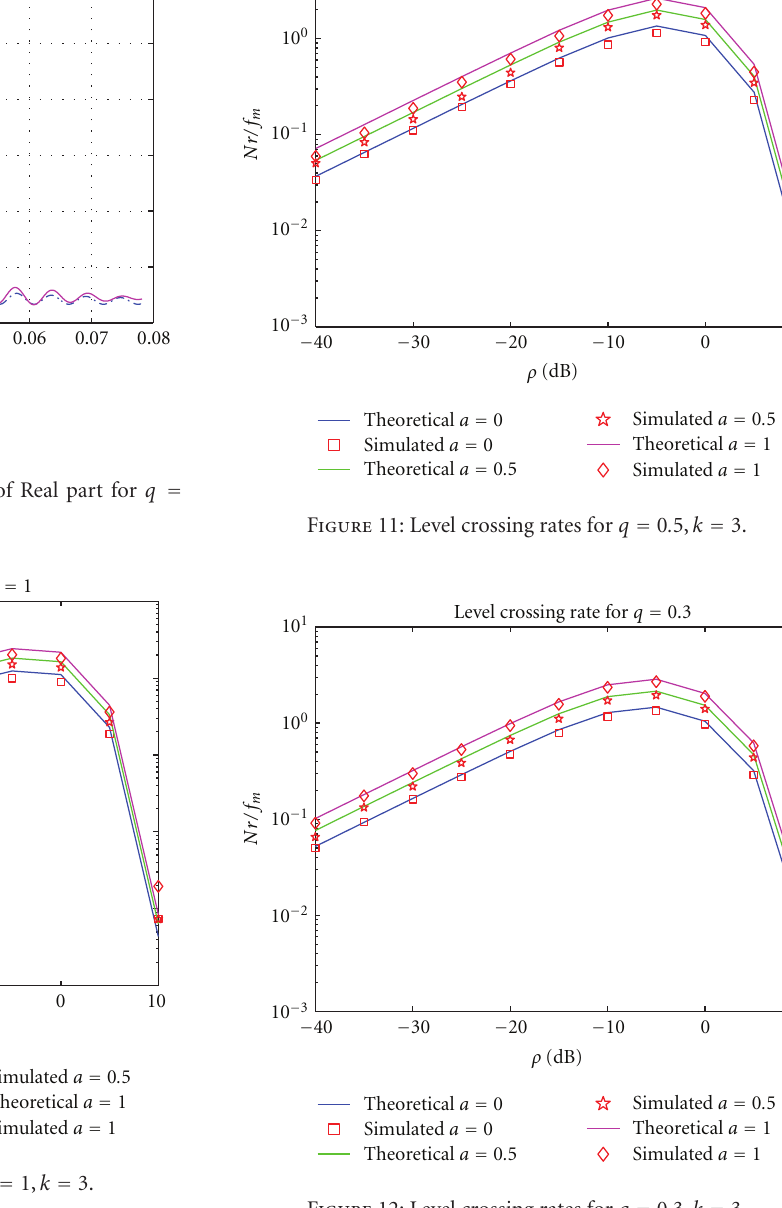
Figure 12: Level crossing rates for q = 0 . 3, k =